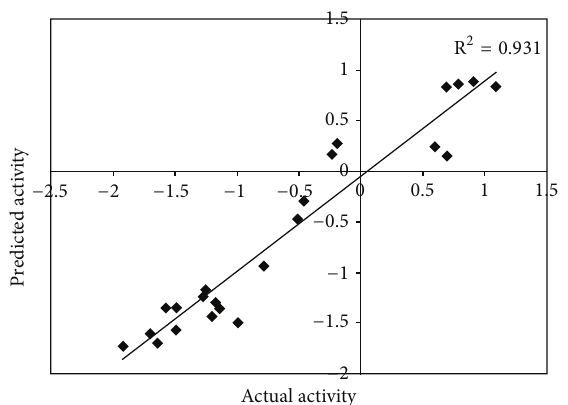
Figure 5: Plot of actual versus predicted values for the test set molecules with the help of PLS statistical